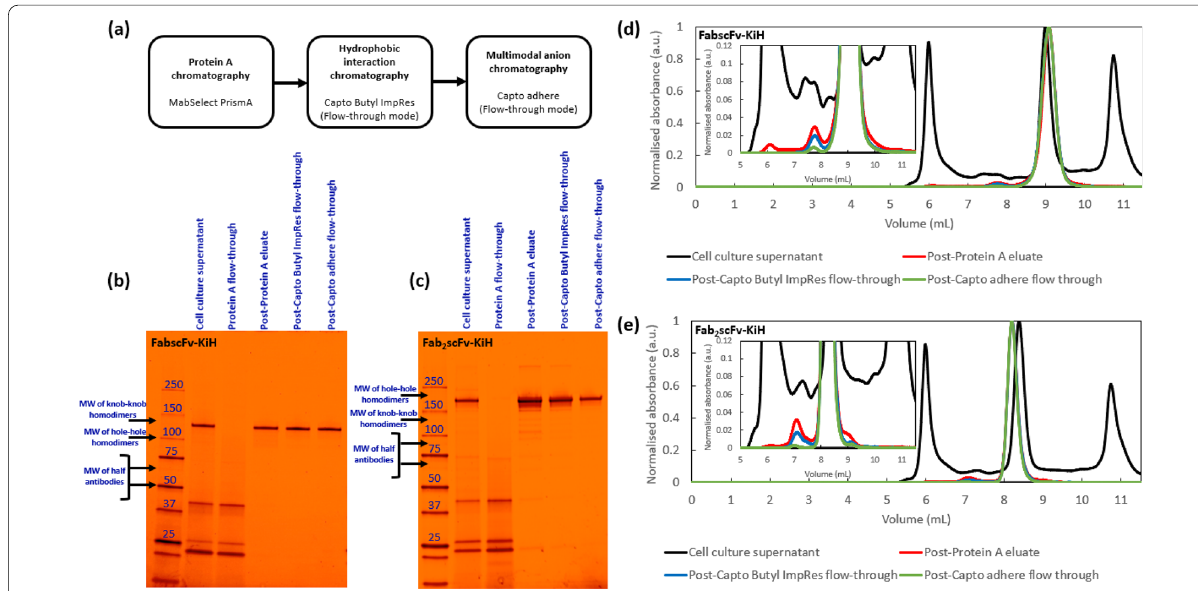
Fig. 6 The schematic purification strategy proposed for KiH bsAbs ( a ). SDS-page gels ( b , c ) and SEC-HPLC chromatograms with zoomed-in insets ( d , e ) illustrating the purity profiles for FabscFv-KiH ( b , d ) and Fab 2 scFv-KiH ( c , e ) obtained in this three-step purification